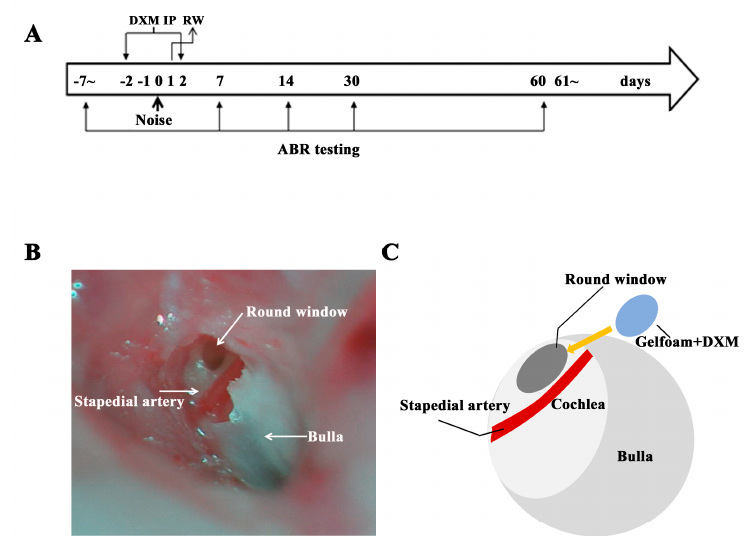
Figure 1. ( A ) Experimental schedule. Mice were exposed to noise on day 0. The auditory brainstem response (ABR) test was performed on days − 7, 7, 14, 30, and 60. Dextromethorphan (DXM) was injected intraperitoneally (IP) on days − 2 to 2 and boosted on day 1 through the round window approach. ( B , C ) Surgical approach for DXM round-window application.